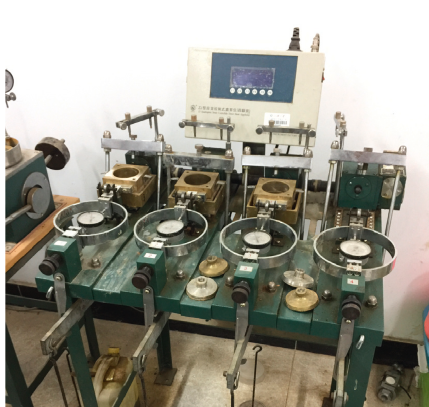
Figure 4: ZJ strain-controlled quadrupole direct shear